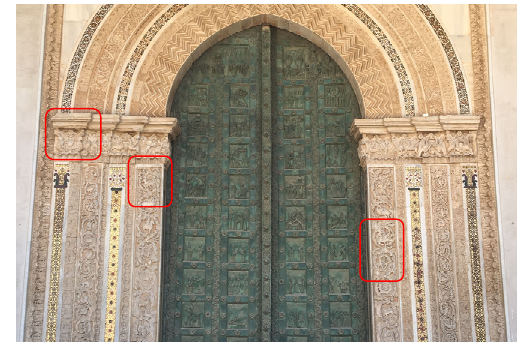
Figure 11. Sculptural elements acquired from a very close range.